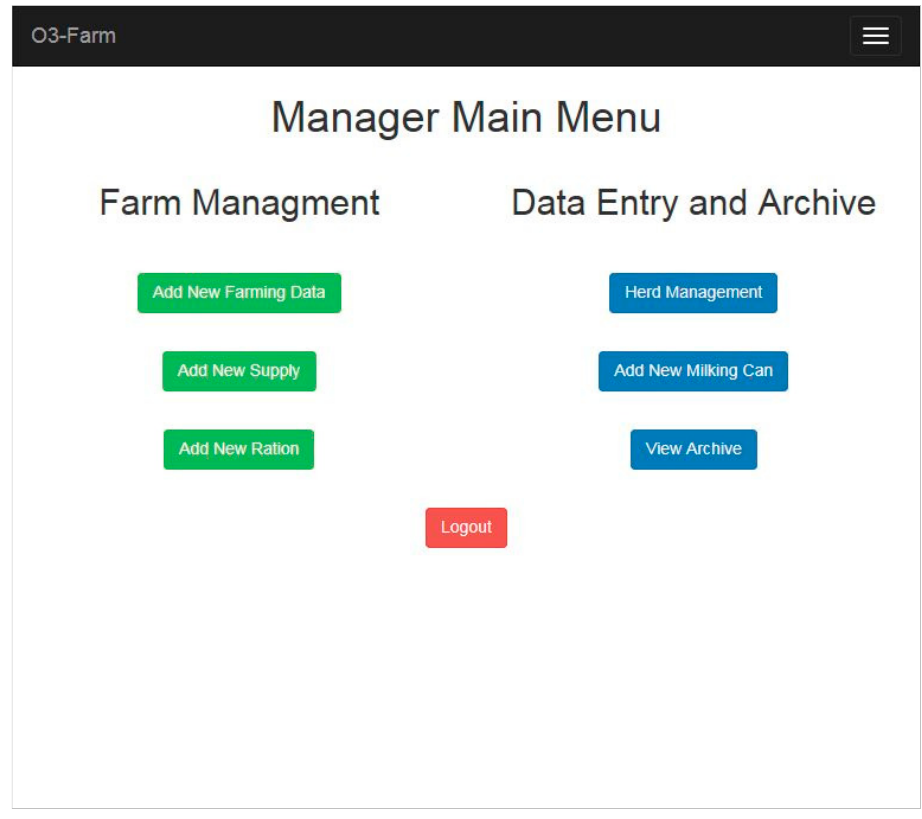
Figure 3. Manager main menu page.